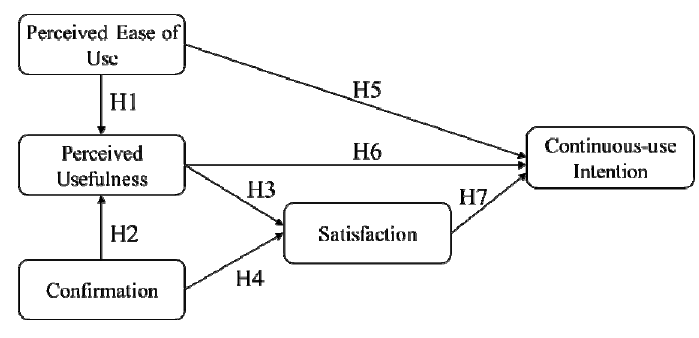
Figure 1. Research model.